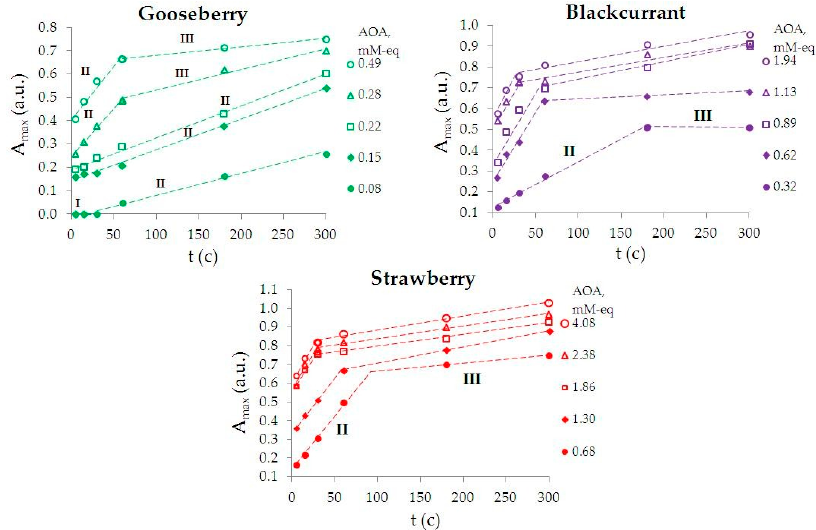
Figure 2. Kinetic curves of the phytosynthesis of phyto-AuNPs suspensions using reaction mixtures containing extracts from gooseberry, blackcurrant and strawberry leaf. Table 1. Phyto-AuNPs’ suspension formation rates ( ν ~d A max / d t ) calculated for growth (II) and saturation (III) sections of the kinetic curves in Figure